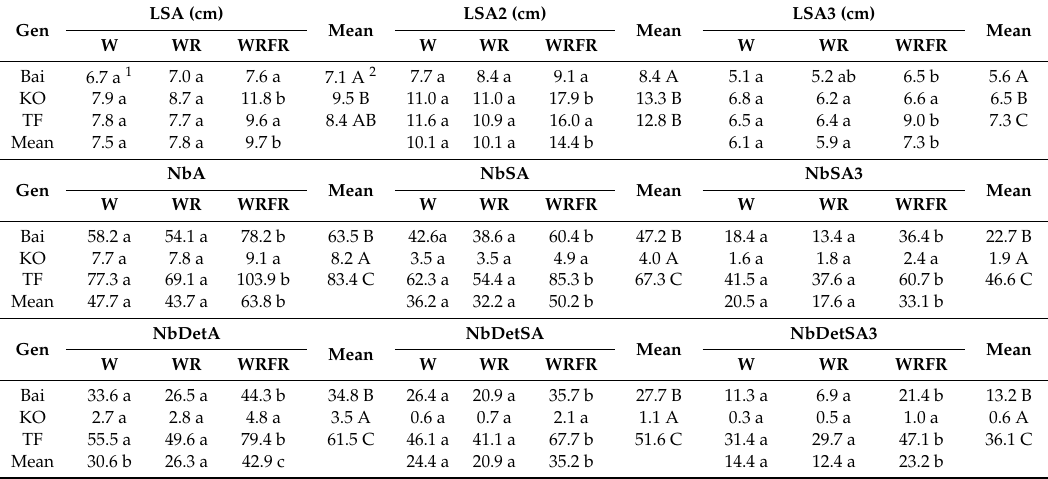
Table 6. Least-square means (LS means) of elongation, branching and flowering variables measured at measurement point 2 and selected for Baipome (Bai), Knock Out ® Radrazz (KO) and ‘The Fairy’ (TF) grown in a climatic chamber under three light conditions: W, WR, and